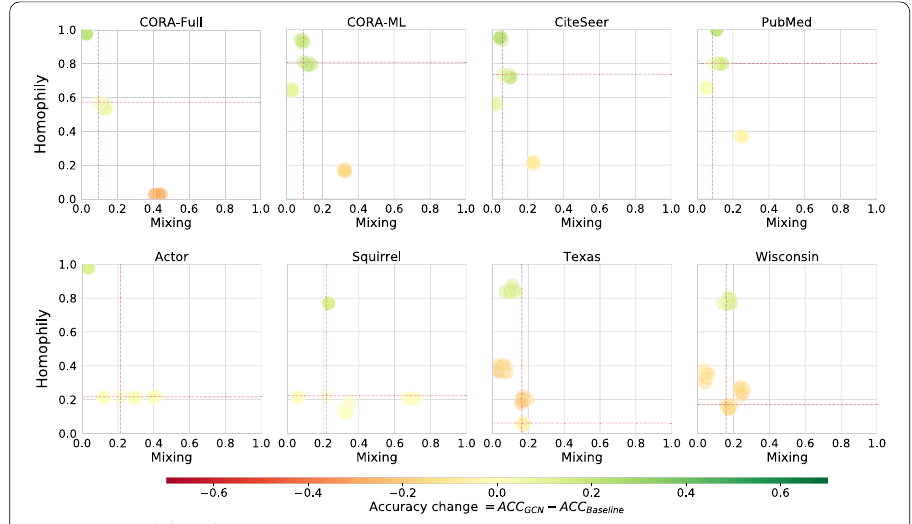
Fig. 13 Homophily and mixing impact on CGCN